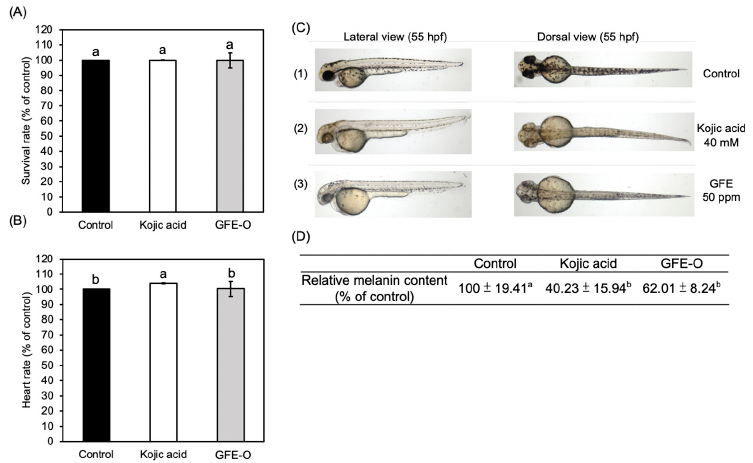
Figure 5. Anti-melanogenic effects of optimal cultured Ganoderma formosanum on zebrafish. Zebrafish were treated with vehicle as control, kojic acid (40 mM), and GFE-O (50 ppm) for 48 h. Survival rate ( A ) and heart rate ( B ) of zebrafish embryos were analyzed as % of control. ( C ) Representative images of zebrafish embryos treated with GFE-O (50 ppm) and kojic acid (40 mM) at 55h post fertilization (hpf) (48 h treatment). Depigmenting efficacy of GFE and kojic acid on zebrafish were photographed under stereomicroscope at the same magnification. ( 1 ) Zebrafish embryo without treatment as a control, ( 2 ) 40mM kojic acid as a positive control, ( 3 ) 50 ppm GFE. ( D ) The melanin content was analyzed and expressed as % of the vehicle as control. Means with different letters indicate that they are significantly different ( p < 0.05). the data were obtained from at least three independent experiments and expressed as means ± SD.